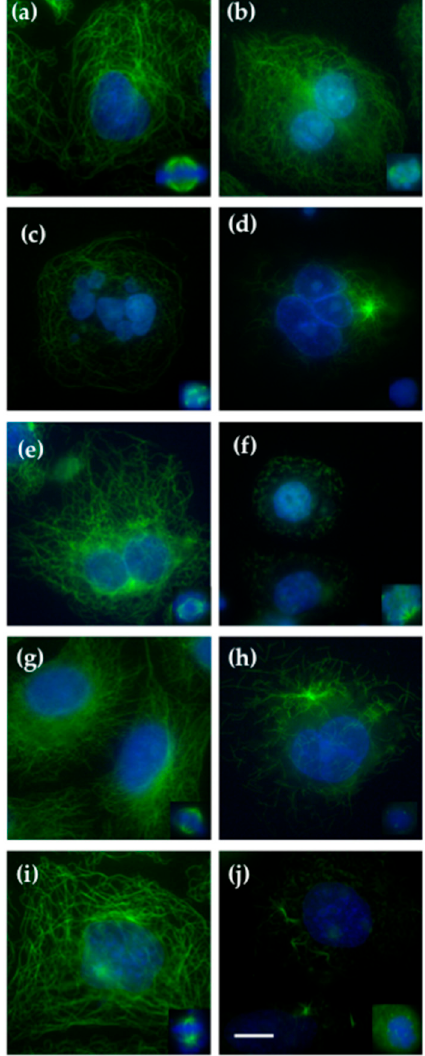
Figure 3. Effect of quinolin-6-yloxyacetamides on the microtubule cytoskeleton network and mitotic spindles. A549 cells were treated either with ( a ) DMSO; ( b ) 100 nM QA 1 ; ( c ) 250 nM QA 1 ; or ( d ) 0.5–1 µM QA 1 ; ( e ) 100 nM QA 2 ; ( f ) 0.5–1 µM QA 2 ; ( g ) 1 µM QA 3 ; ( h ) 3–5 µM QA 3 ; ( i ) 10 nM vinblastine; or ( j ) 50 nM vinblastine. Microtubules are stained with α -tubulin antibodies ( green ); DNA was stained with Hoechst 33342 ( blue ). The insets are mitotic spindles from the same preparations. Scale bar, 10 µm. All panels and insets have the same magnification.